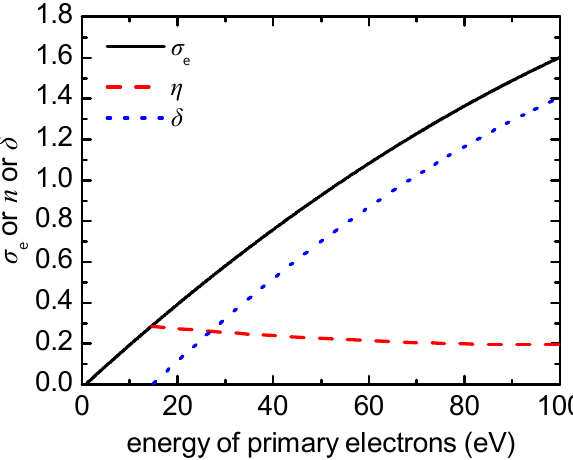
Figure 2. The total electron yield, σ e , the secondary electron emission yield, δ , and the backscattering coefficient, η , being utilized in the SEEE model.